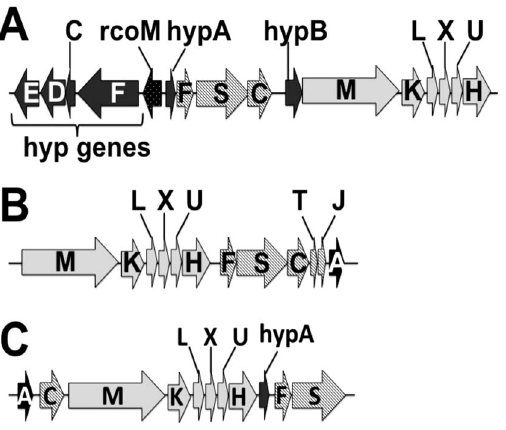
Figure 2. Organism Overview for Rubrivivax gelatinosus CBS. There are 643 subsystems, 4852 coding sequences, and 58 RNAs.